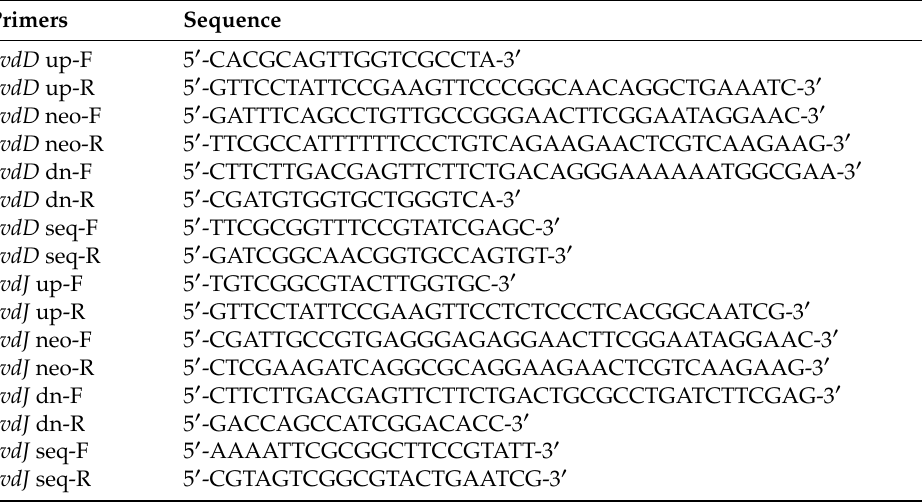
Table 2. Oligonucleotide primers used in this